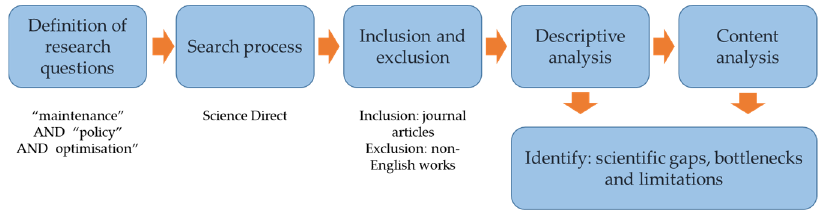
Figure 2. Methodological process of the systematic literature review based on searching in Science Direct.